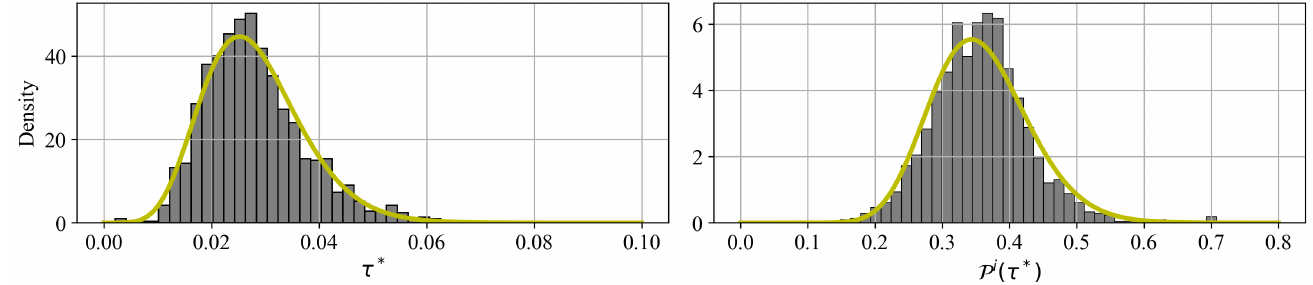
Figure 4. Density histogram of the calculated values of τ ∗ and P i ( τ ∗ ) , as defined by Equation